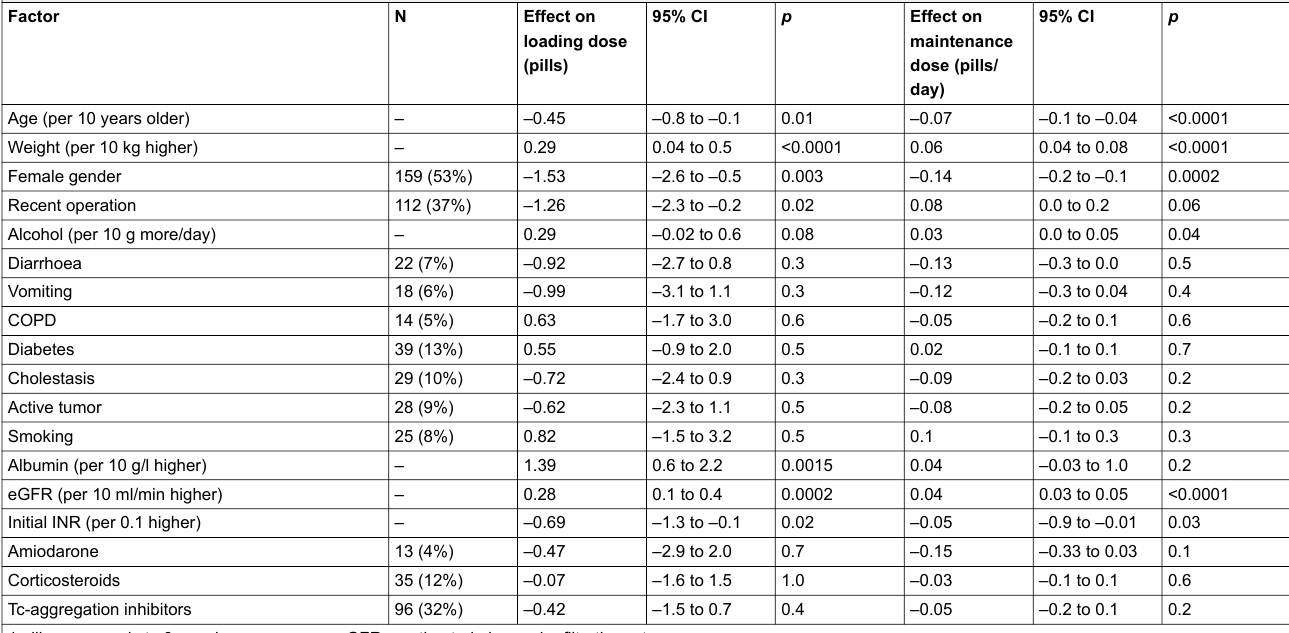
Table 2: Univariate clinical predictors of loading dose and maintenance dose.